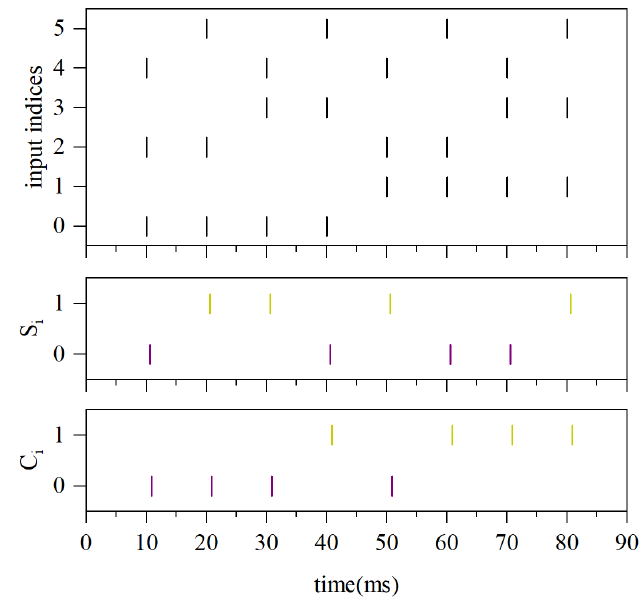
Figure 14. The test results of the full adder.